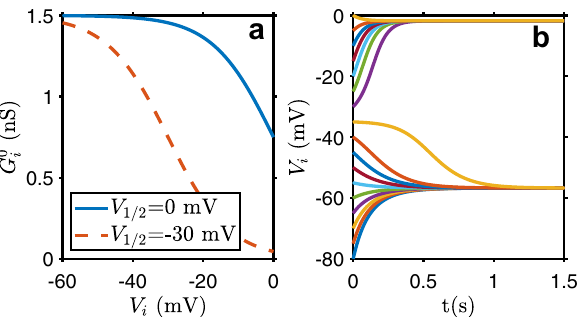
Figure 1. (a) Single cell gap junction ionic conductivity as a function of the cell membrane electric potential, as given by Eq. (4), with the parameters used in this work ( V 1 / 2 = 0 mV) and the ones used in 31 ( V 1 / 2 = − 30 mV). (b) Evolution in time of an isolated cell membrane electric potential for different initial membrane electric potential values. There are two stable points, at ≃ − 2 mV and ≃ − 57 mV, with the separation taking place at ≃ − 35